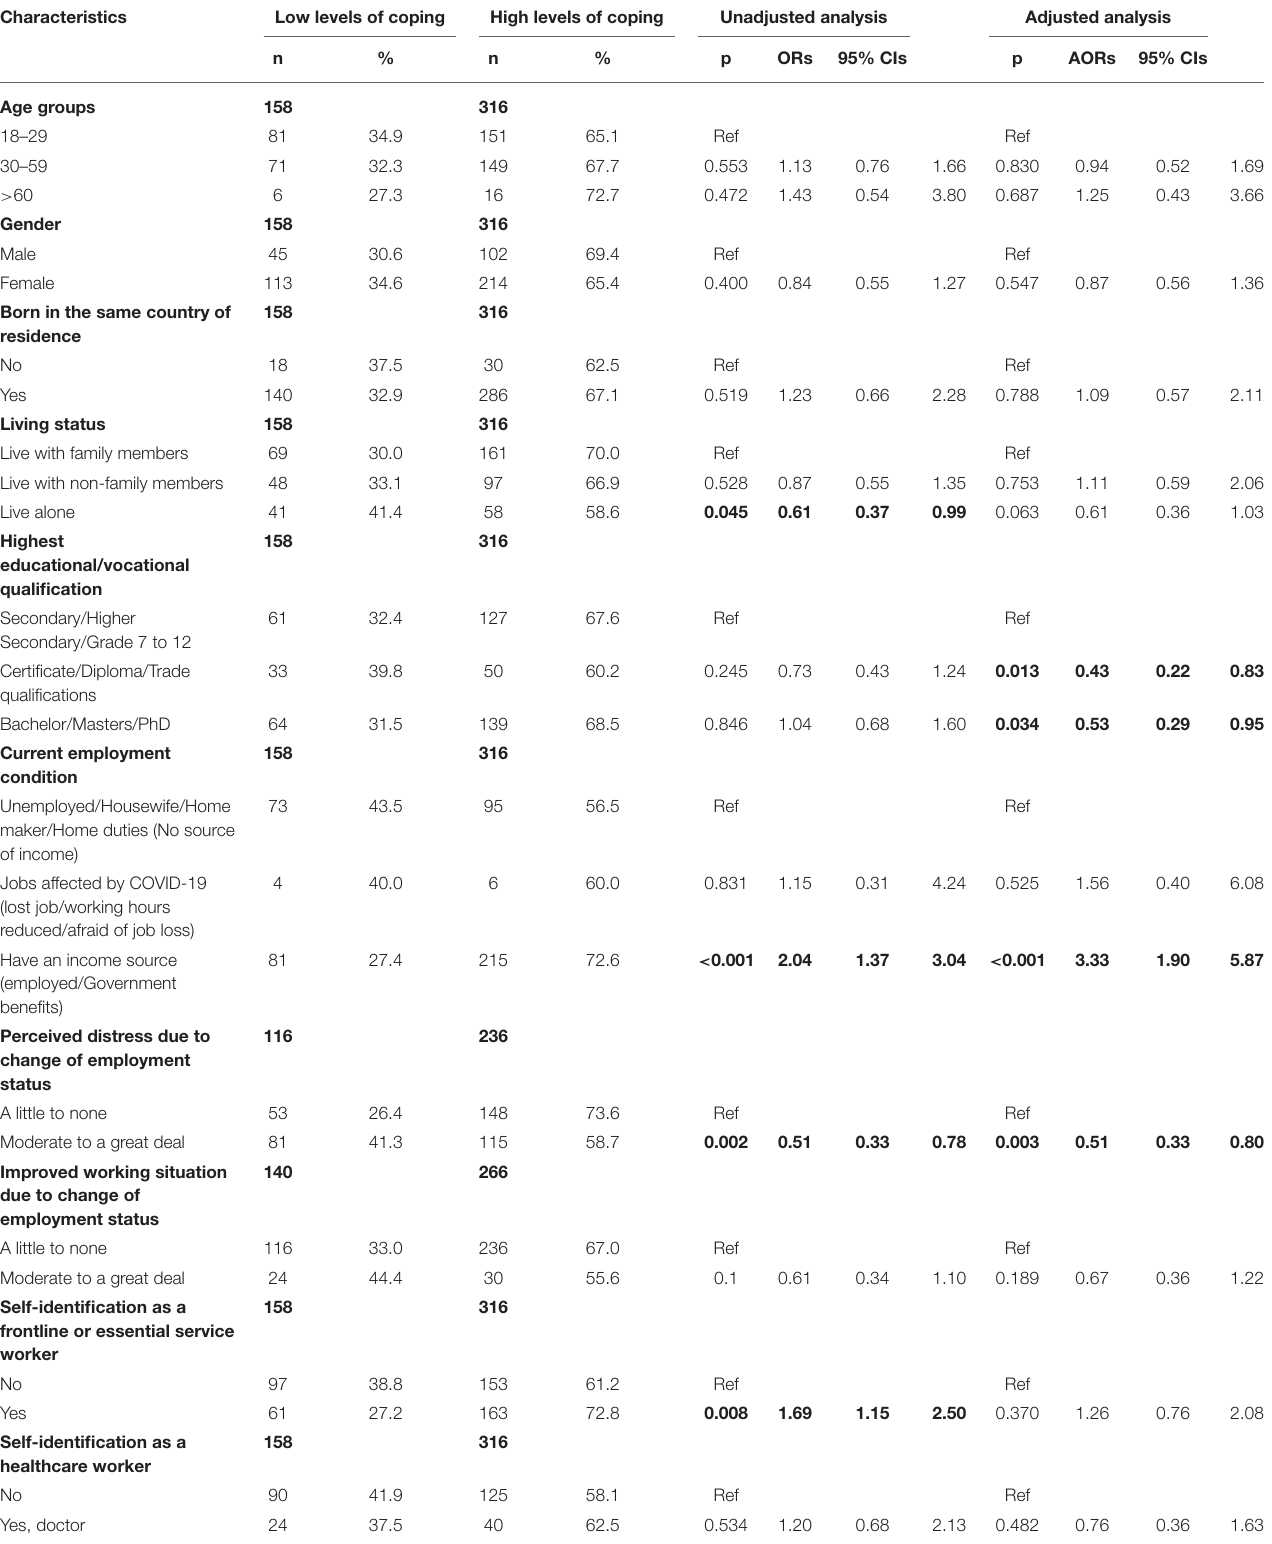
TABLE 4 | Factors associated with coping among the study population (based on BRCS scoring). Characteristics Low levels of coping High levels of coping Unadjusted analysis Adjusted